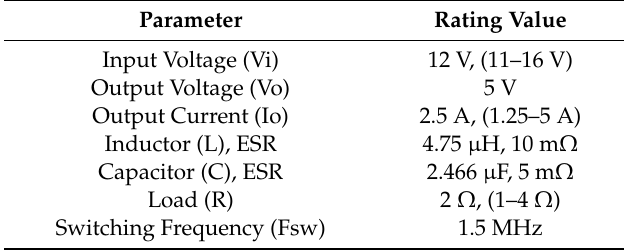
Table 1. Design parameters of the converter.